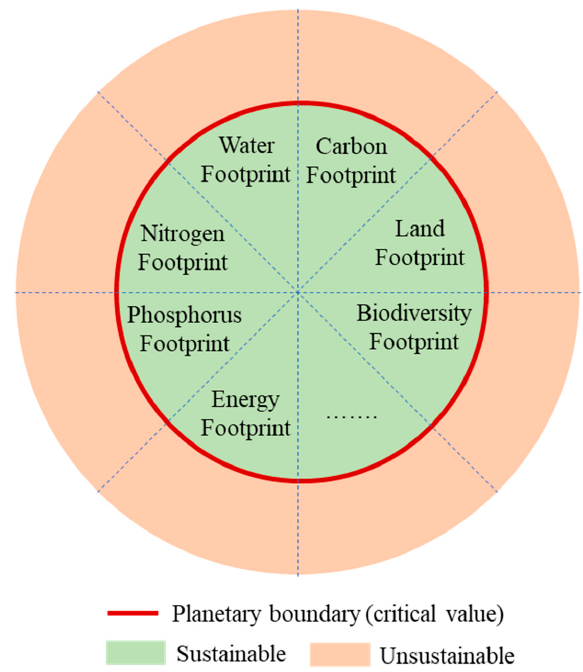
Figure 9. Sustainability assessment based on footprint family and planetary boundaries.